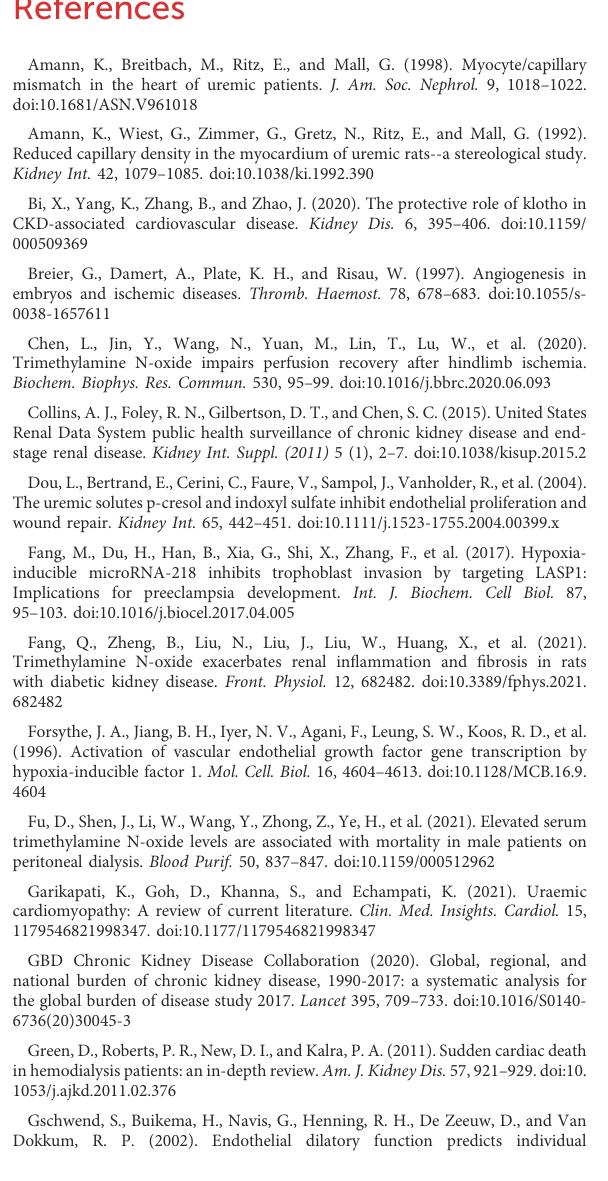
SUPPLEMENTARY FIGURE S4 Dietary choline (1.2%) does not affect cardiac capillary density in CD1 mice. (A) Representative micrographs of immunohistochemistry staining of CD31 in the heart. Scale bar = 50 μ m. (B) Graphical representation of capillary density analysis. (C) The protein levels of CD31 were measured by western blotting. (D) Graphic representation of relative abundance of CD31 normalized to GAPDH. The data are presented as the mean ± SD. n = 6 in each group. SUPPLEMENTARY FIGURE S5 FG-4592 elevates Hb, RBC and Hct in 5/6Nx mice on a high-choline diet. (A – C) Hb (A) ,RBC (B) andHct(C)weredetectedinbloodcollectedfrom mice at the end point of experiment. The data are presented as the mean±SD.* p < 0.05and** p < 0.01 vs. SHAMgroup;# p < 0.05and## p < 0.01 vs. CKDgroup. & p < 0.05and && p < 0.01 vs. CKD+Cholinegroup. n = 6 in each group. Hb, Hemoglobin; RBC, Red blood cell; Hct,